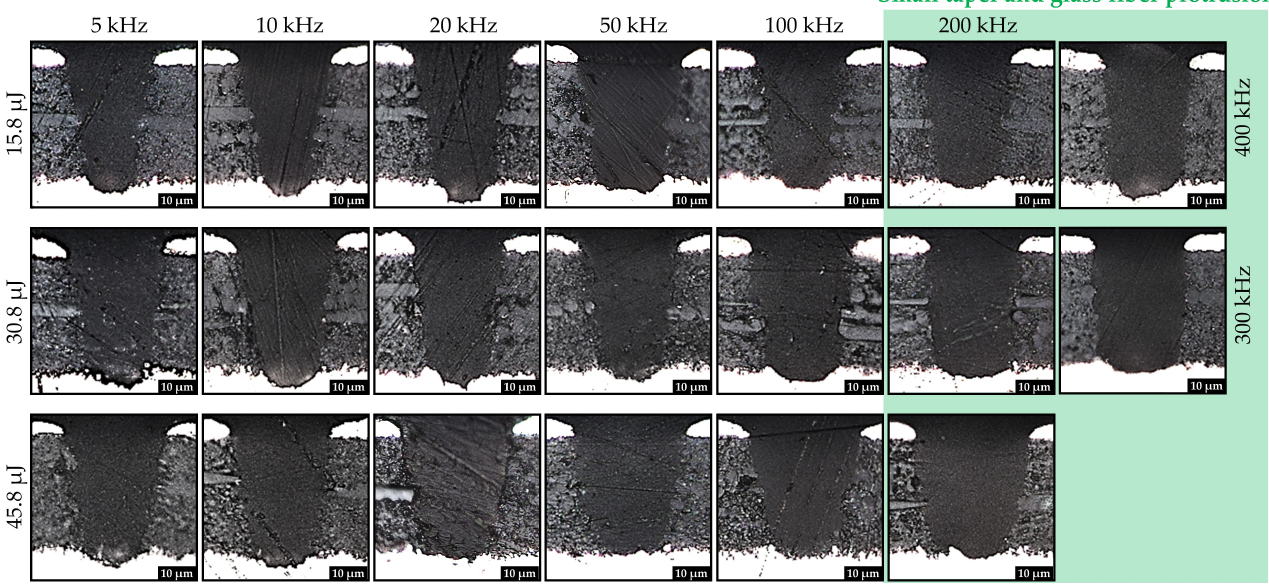
Figure 7. Selected cross sections of microvias in FR-4 PCB material at different laser pulse energies of E = 15.8–45.8 µJ and laser pulse repetition rates of f = 5–400 kHz using a laser pulse duration of τ = 2 ps, observing an decrease in taper for laser pulse repetition rates of more than 100